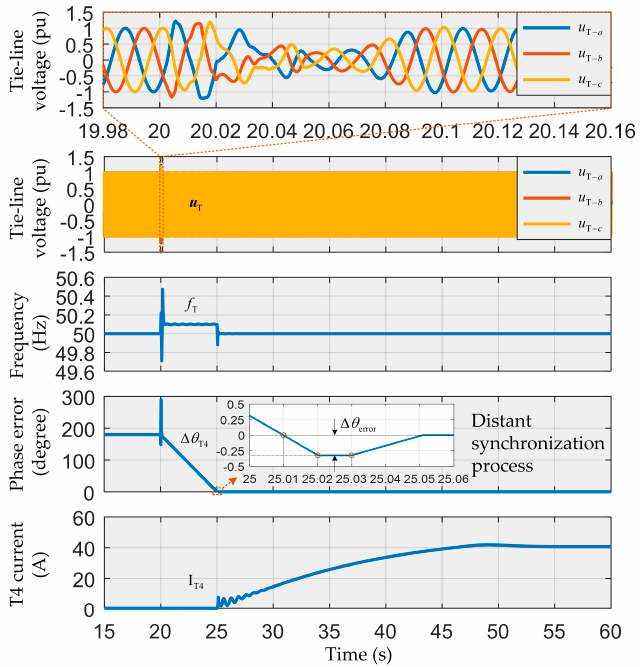
Figure 6. Major changes of electric quantity at the distribution network (DN) side in Scenario 1. Electronics 2020 , 9 , 18